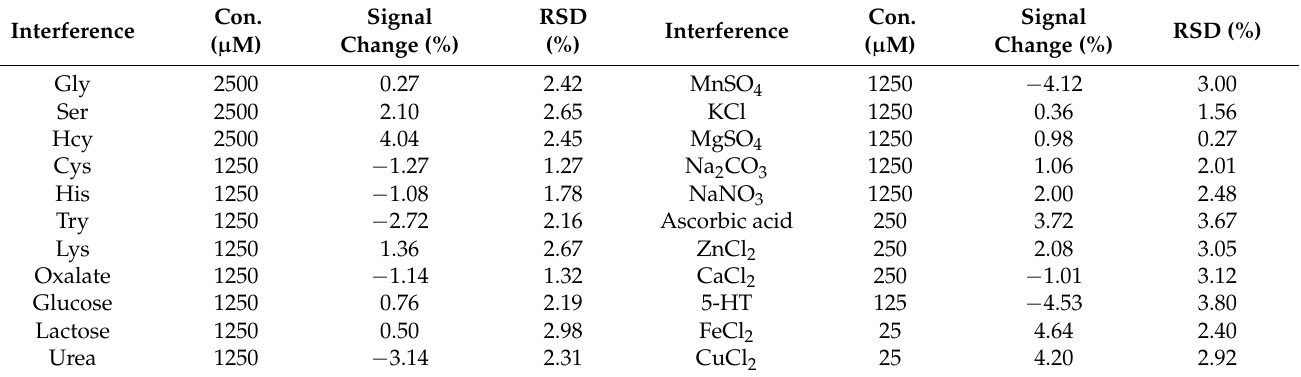
Table 2. Interference effect on the determination of 12.5 µ M DA (n =